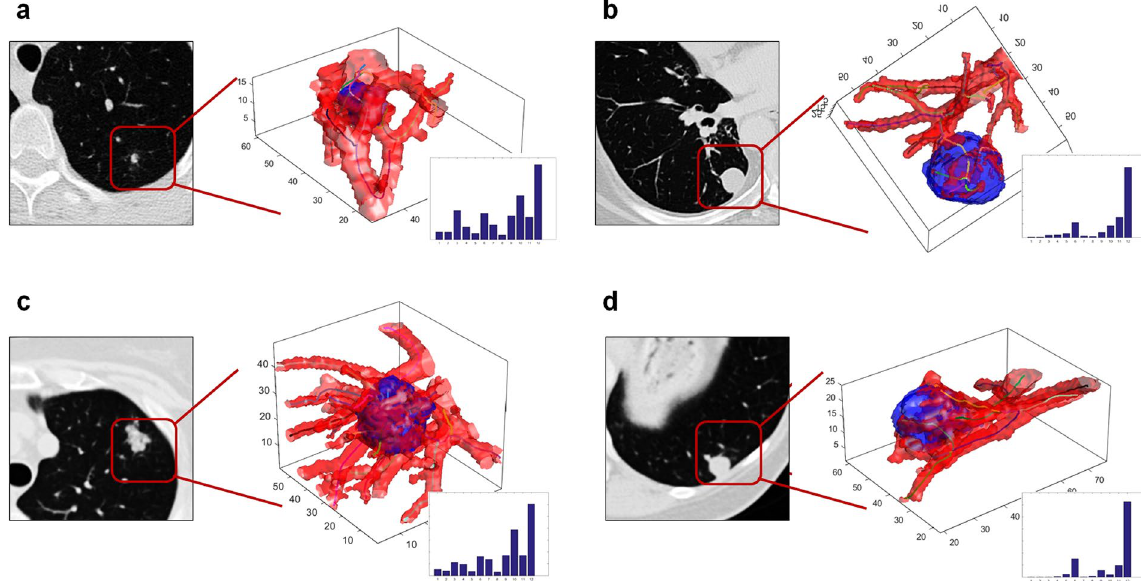
Figure 3. 3D rendering of 2 adenocarcinomas ( a , c ) and 2 granulomas ( b , d ). Corresponding feature vector of each nodule in the form of a bar graph is illustrated in the bottom left of each individual panel. The corresponding height of each column is a reflection of the expression value for each of the top 12 discriminating and QVT features.